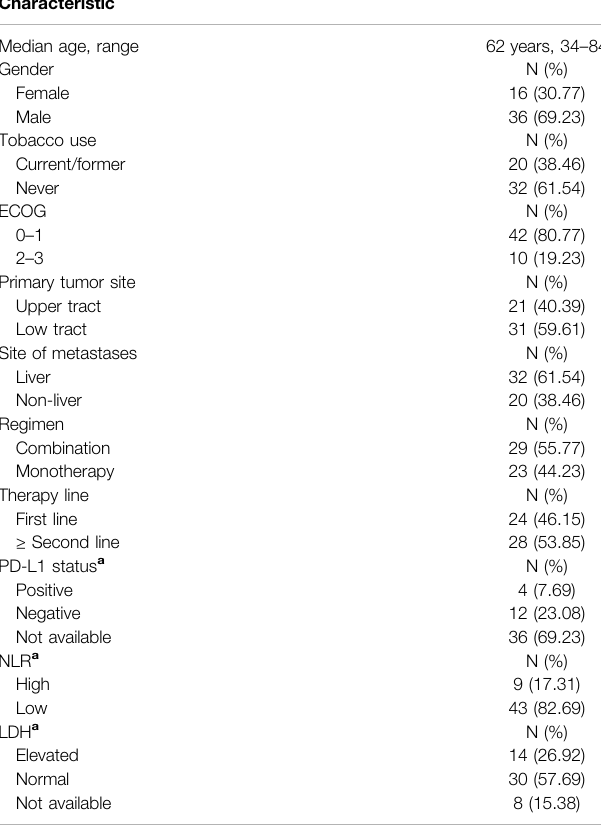
TABLE 1 | Characteristics of included